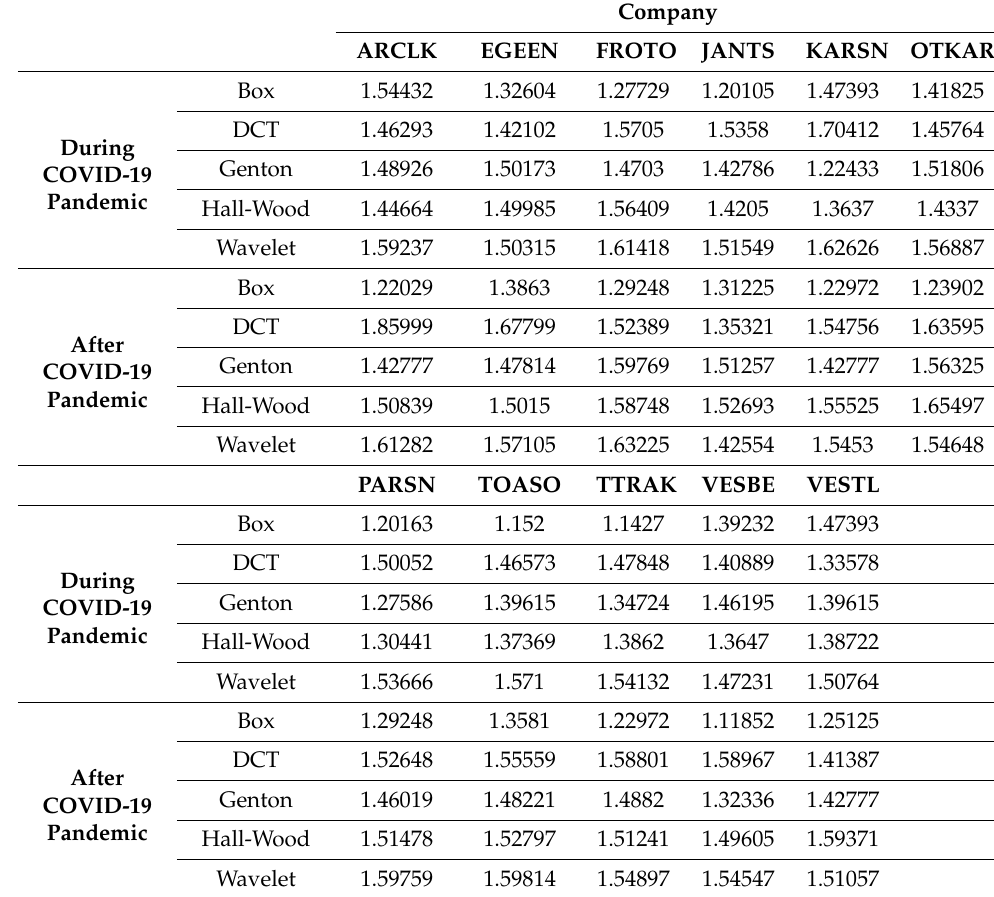
Table A7. Fractal dimensions for the machineries sector.